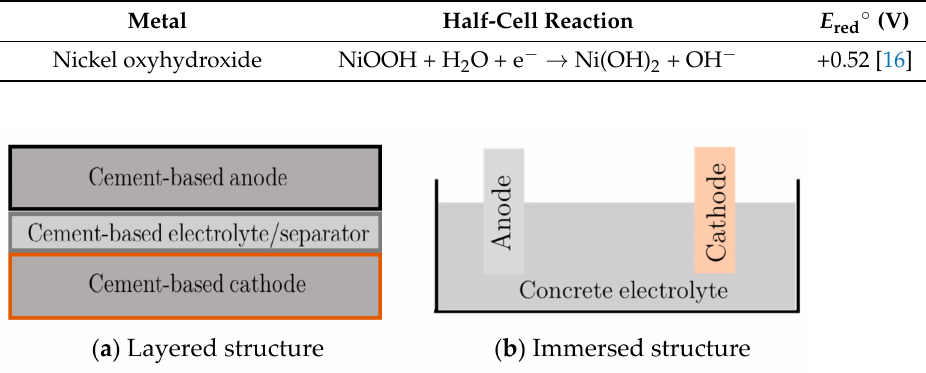
Figure 1. Two common cell arrangements of the concrete batteries: ( a ) the layered structure and ( b ) the immersed structure.